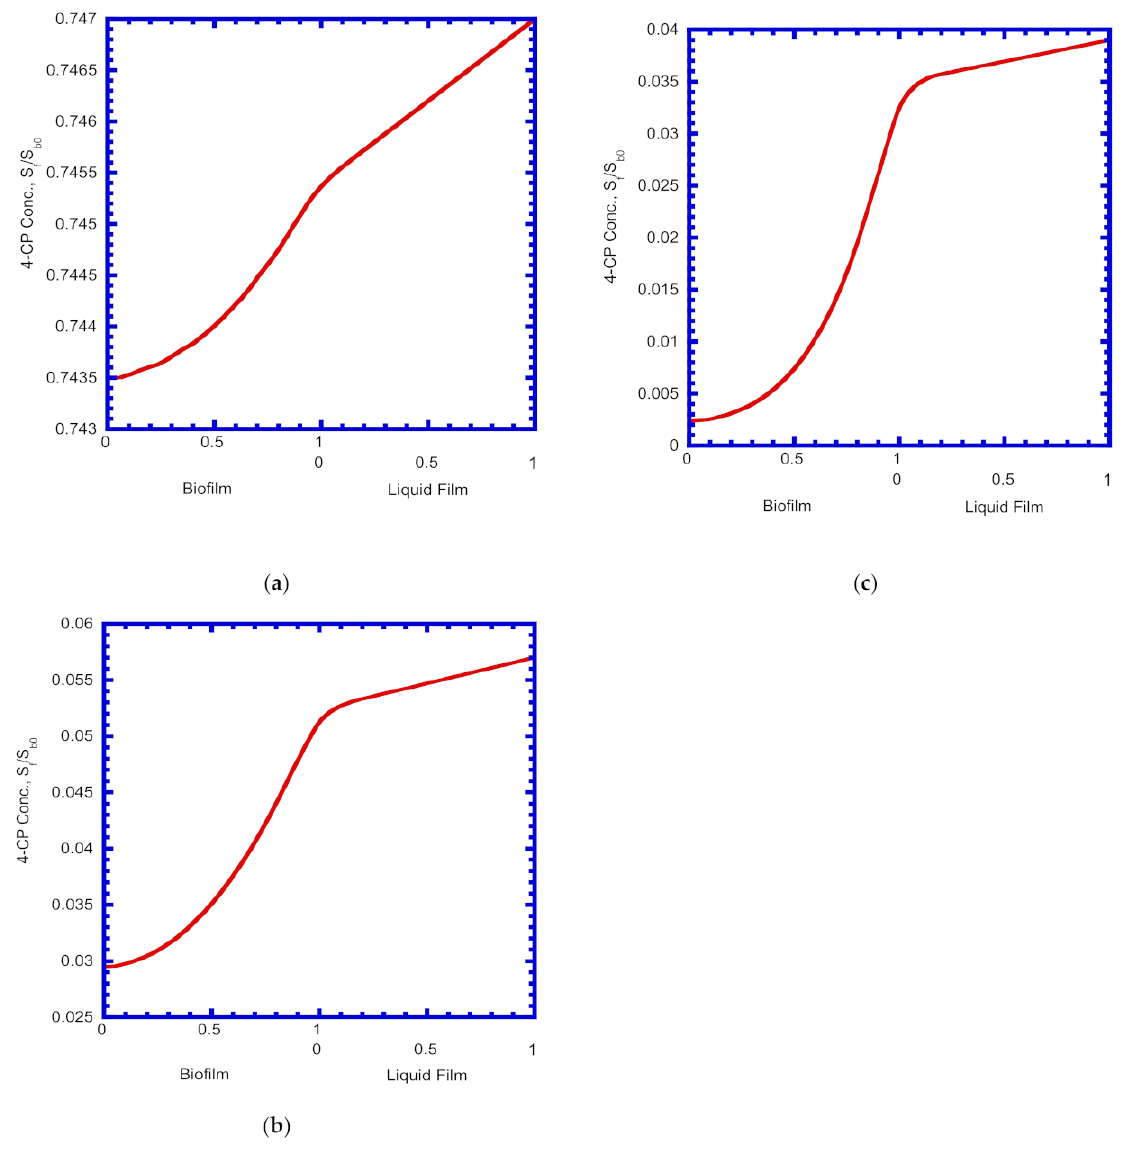
Figure 7. 4-CP concentration profile in the liquid film and biofilm at ( a ) 10.58 days, ( b ) 13 days, and ( c ) 40